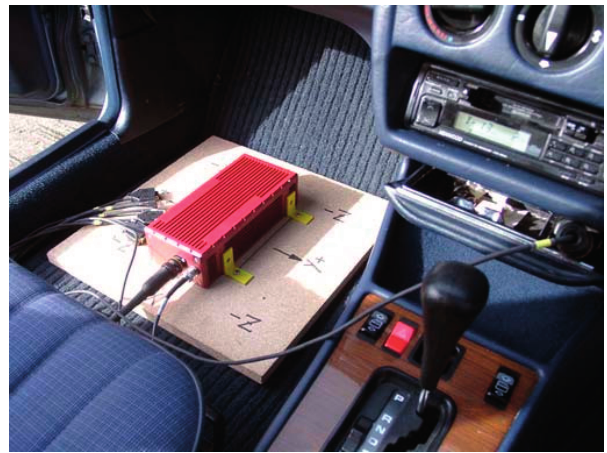
Figure 9. Testing car and system.